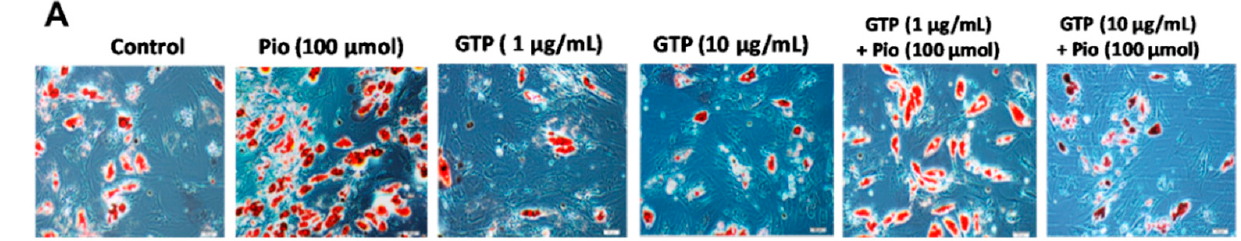
Table 1. Primer sequences used in real-time PCR.